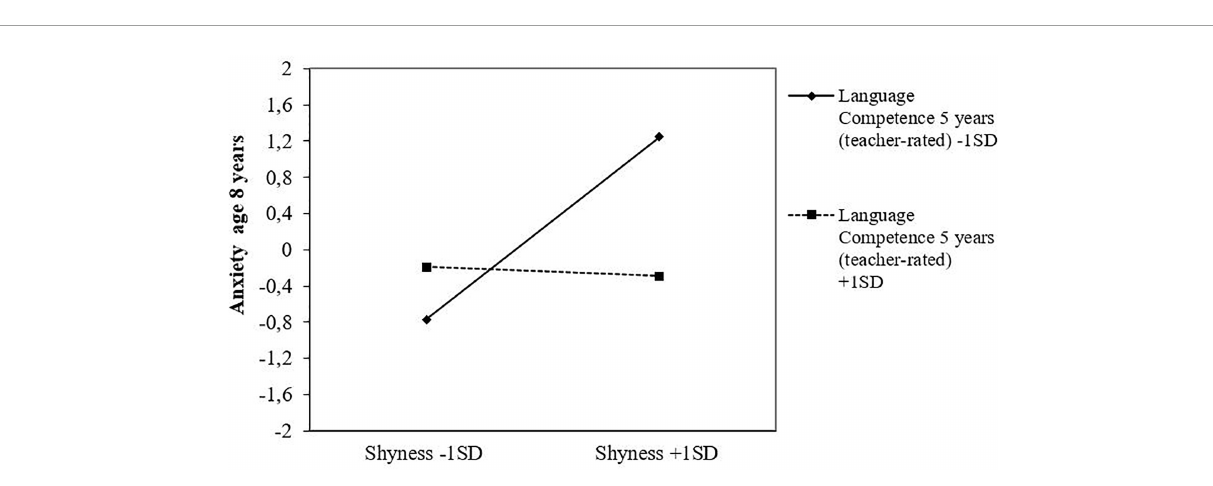
FIGURE2 Language competencies at age 5 years as a protective factor in the association between childhood shyness and anxiety symptoms at age eight, as reported in standard